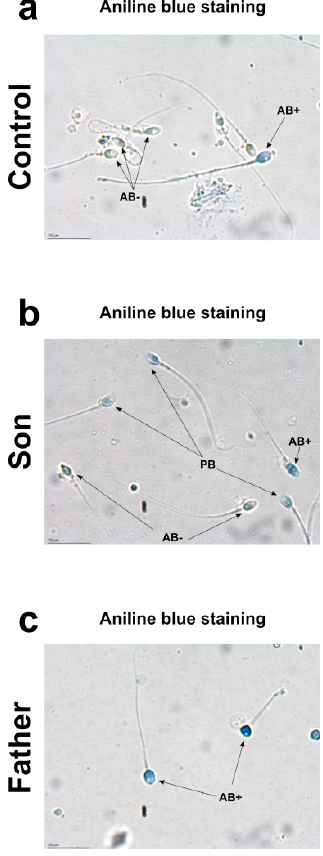
Figure 1. Aniline blue staining from control 1 sample ( a ), son ( b ) and father ( c ).